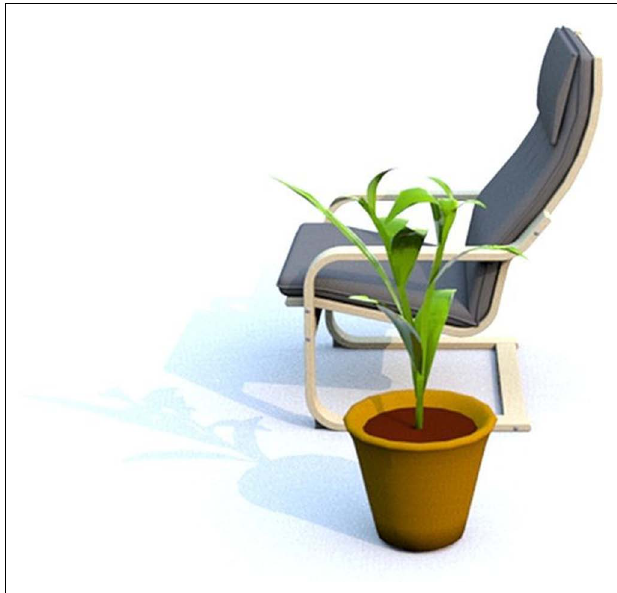
FIGURE 1 | Reference object (armchair) rotated 90 ◦ with located object "in front of it" (relative reference frame) or “to the left of it” (intrinsic reference frame)